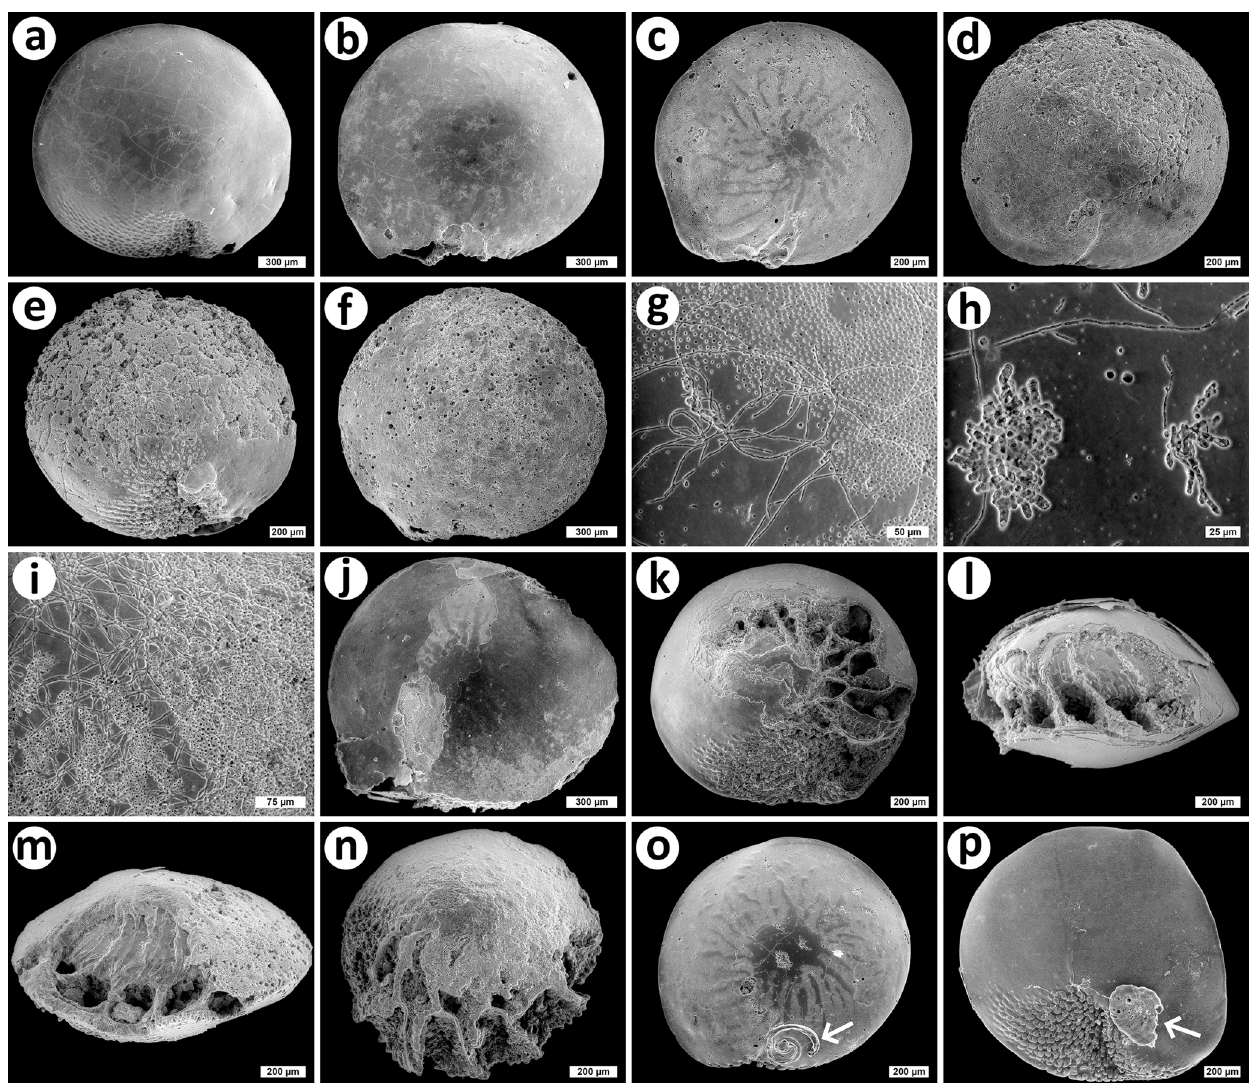
Figure 3. Examples of bioerosion, abiotic dissolution and epiphytic colonization of shells of the invasive foraminiferan Amphistegina lobifera visualized by scanning electron microscopy. Amphistegina lobifera substrate shells displaying low (a) , medium (b, c) and high (d, e, f) levels of bioerosion (cf. Table 1); (g, h, i) typical bioerosion traces found in the substrate shells; (j–n) various degrees of abiotic dissolution, sometimes combined with bioerosion (j, m, n) ; (o, p) examples of epiphytes on A. lobifera shells (arrows). Bars are 300µm (a, b, f, j) , 200µm (c, d, e, k–p) , 75µm (i) , 50µm (g) and 25µm (h) . The shells were collected by Martin Vohník, and all photos were taken by Ji ˇ rí Macha ˇ c under Martin Vohník’s